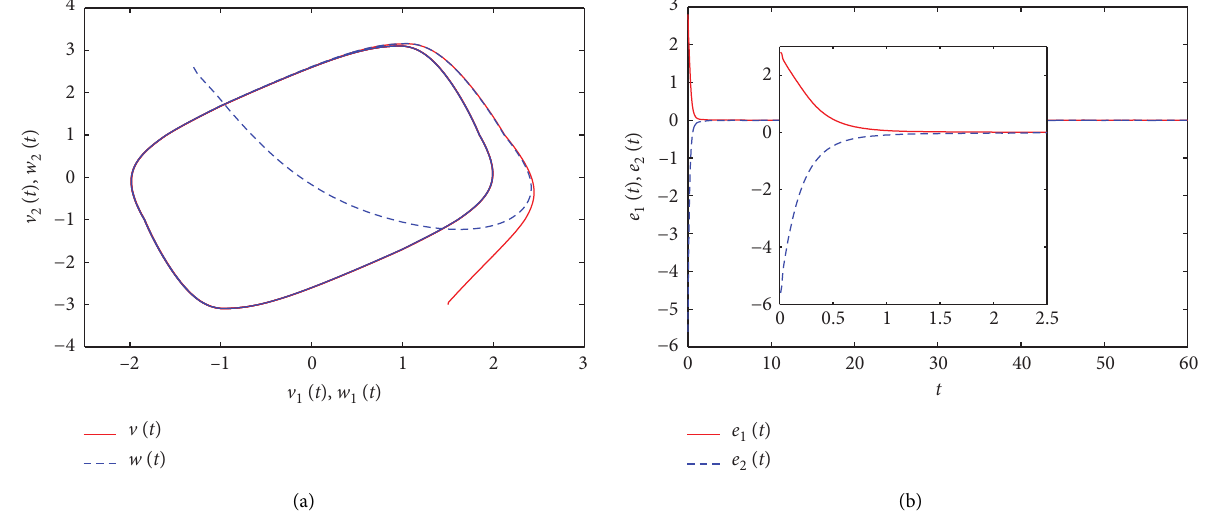
( t ) � 3 . 4 e ( t ) + 0 . 5sign ( e ( t )) ,u ( t ) � 2 . 3 e ( t ) + 0 . 7sign ( e ( t )) 1 1 1 2 2 2